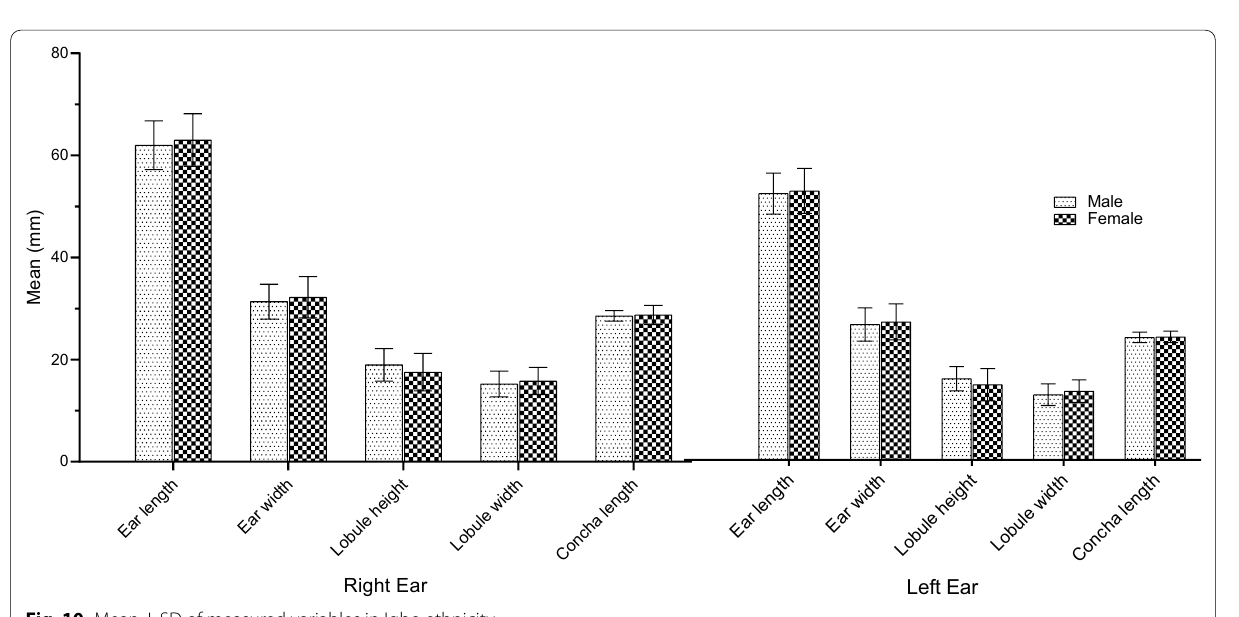
Fig. 9 Mean SD of measured variables in Hausa ethnicity ±